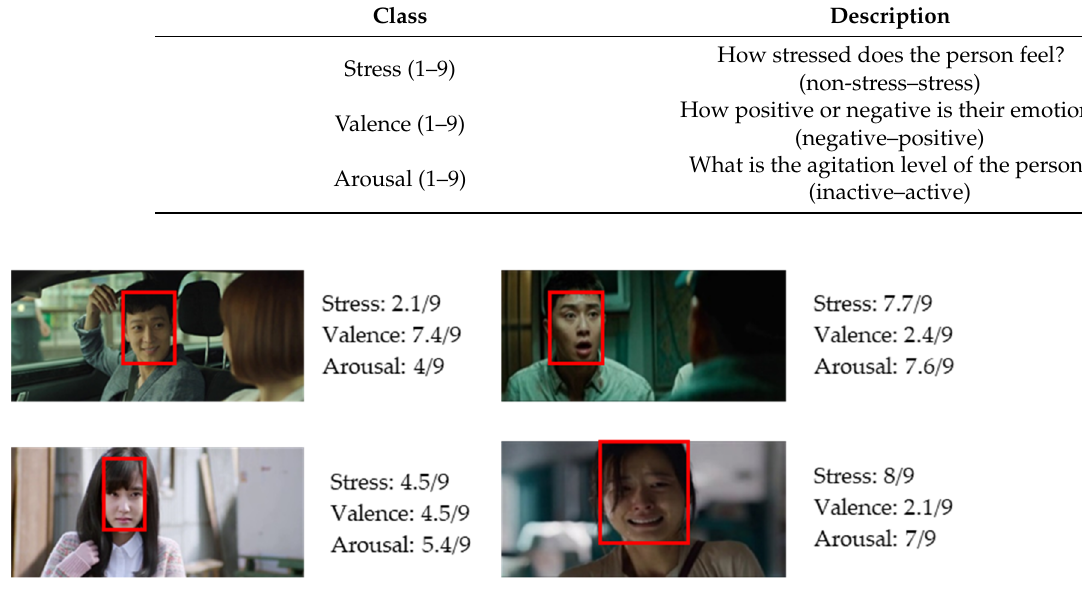
Table 2. Description of the stress and dimensions of valence and arousal.